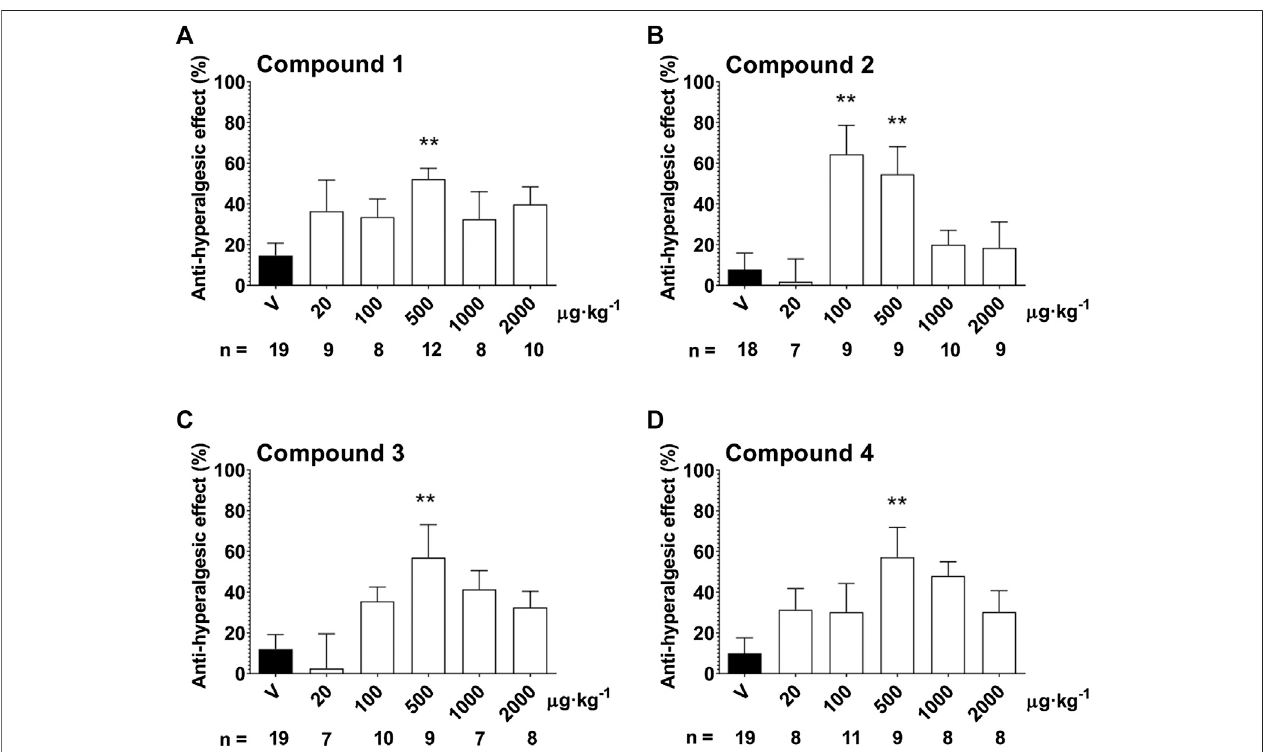
FIGURE 5 | Anti-hyperalgesic effect of a single oral treatment with Compounds 1 – 4 7 days after partial tight ligation of the sciatic nerve in the mouse. Columns represent anti-hyperalgesic effect 60 min after treatment with the respective test compound compared to pre-treatment control values. Each column represents the mean + S.E.M. of n . Data were analyzed with one-way ANOVA Bonferroni ’ s Multiple Comparison Test (* p < 0.05, ** p < 0.001 vs. vehicle control values).